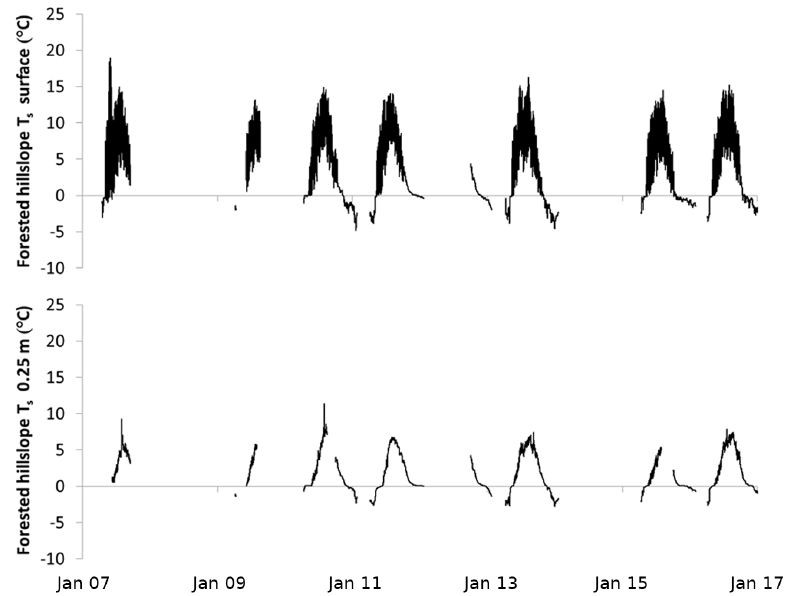
Figure 12. Half-hourly surface and 0.25m soil temperatures from one of the forested hillslope soil moisture nests from 2007 to 2016.